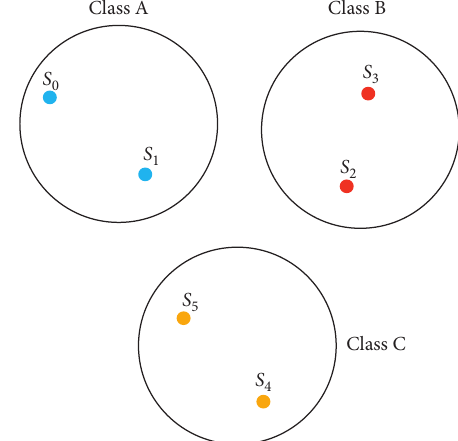
Figure 7: The simple example with six samples in classes A, B, and